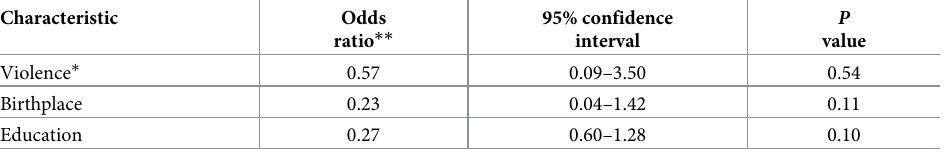
Table 4. Logistic regression analysis of characteristics of inmates and their association with T . gondii infection. Characteristic Odds ratio